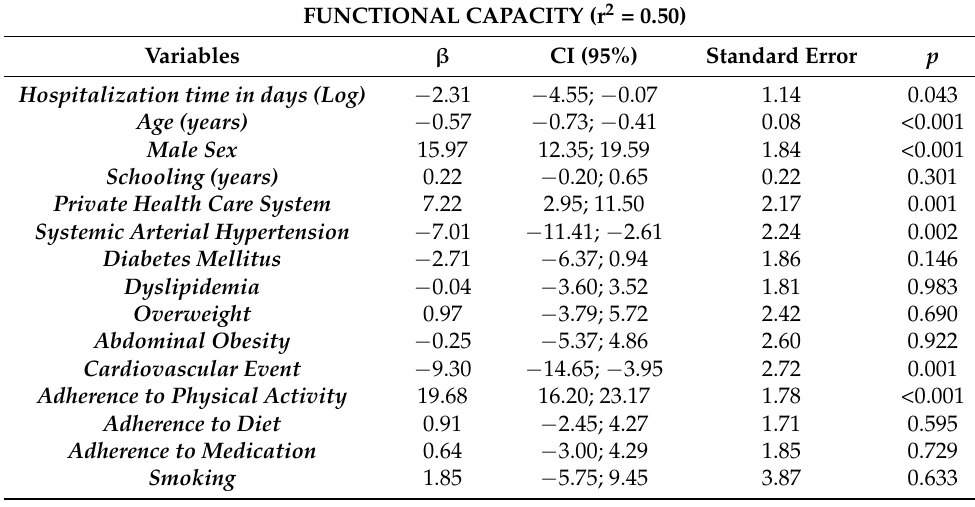
Table 5. Multiple linear regression models for QOL of patients at 180 days after ACS, Aracaju, Brazil. FUNCTIONAL CAPACITY (r 2 =